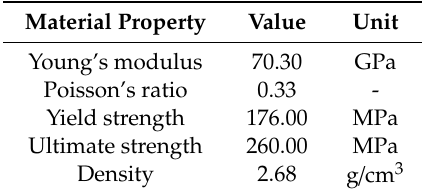
Figure 4. Stress–strain curve of Al 5052-H32. Table 2. Material properties of Al 5052-H32.